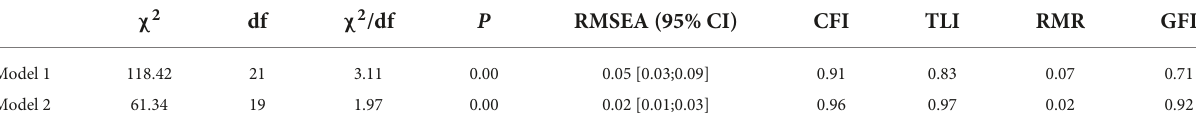
TABLE 3 Goodness-of-fit indices for AS (original version and version with item 1 removed) in Spanish university